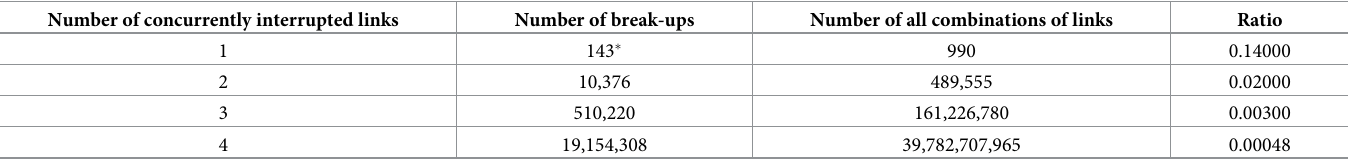
Table 1. The state space for the Zlı´n region. Number of concurrently interrupted